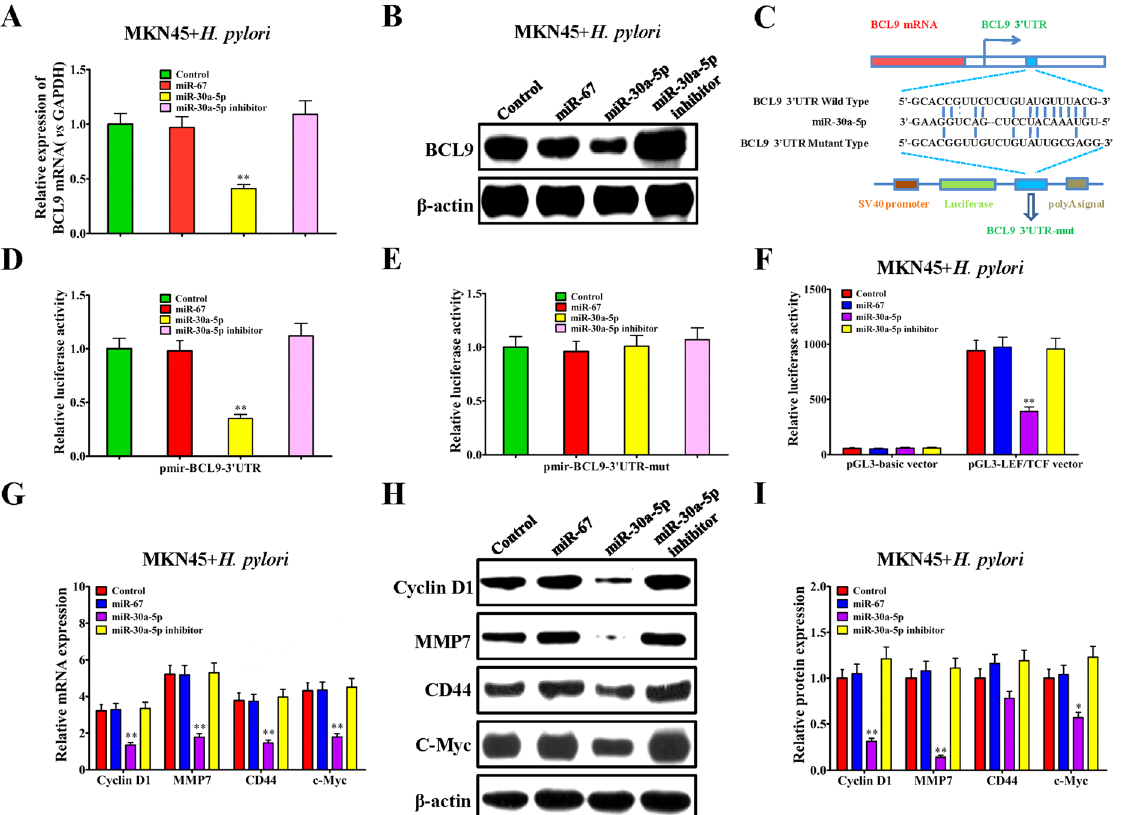
Figure 4. Regulation of miR-30a-5p on the BCL9-TCF/LEF signaling pathway in H. pylori -infected gastric cancer cells. ( A ) qRT-PCR assay for the effect of miR-30a-5p mimic and miR-30a-5p inhibitor on BCL9 mRNA expression in H. pylori -infected MKN45 cells, normalized to control H. pylori -infected MKN45 cells. ( B ) Western blot assay for the effect of miR-30a-5p mimic and miR-30a-5p inhibitor on BCL9 protein expression in H. pylori -infected MKN45 cells. ( C ) Sequence alignment of the BCL9 3 ′ UTR with wild-type (WT) versus mutant (mut) potential miR-30a-5p targeting sites. ( D , E ) Luciferase reporter activity assay of wild-type, mutant BCL9 3 ′ UTR reporter in MKN45 cells overexpressing miR-30a-5p in HEK293T cells, normalized to control H. pylori -infected MKN45 cells. ( F ) Luciferase reporter activity assay for the effect of miR-30a-5p mimic and miR- 30a-5p inhibitor on the LEF/TCF promoter in H. pylori -infected MKN45 cells, normalized to control H. pylori - infected MKN45 cells. ( G ) qRT-PCR assay for the effect of miR-30a-5p mimic and miR-30a-5p inhibitor on the transcriptional activity of β -catenin downstream target genes including Cyclin D1, MMP7, CD44 and c-Myc in H. pylori -infected MKN45 cells, normalized to control H. pylori -infected MKN45 cells. ( H ), ( I ) Western blot and quantitative assay for the effect of miR-30a-5p mimic and miR-30a-5p inhibitor on the protein expression of BCL9 and β -catenin downstream target genes including Cyclin D1, MMP7, CD44 and c-Myc in H. pylori - infected MKN45 cells, normalized to control H. pylori -infected MKN45 cells. Data are shown as mean ± SD; n = 3. * p < 0.05, was considered as statistically significant, ** p < 0.01, was considered as statistically highly